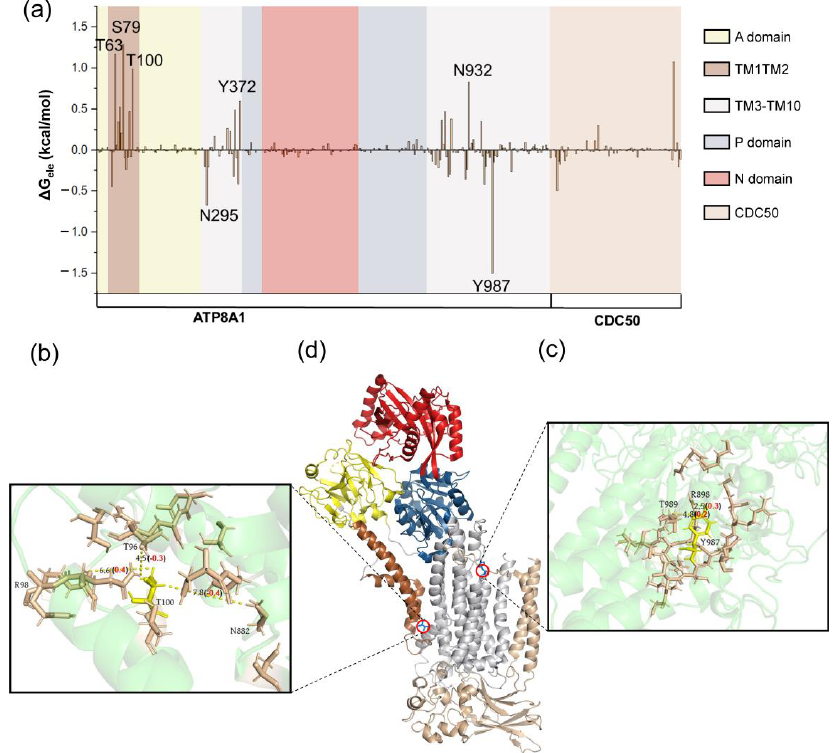
Figure 5. ( a ) The polar contribution of residues for structures I1 and T1. The interaction map of T100 ( b ), Y987 ( c ) and their corresponding position in the P4-ATPase ( d ). The polar residues are colored